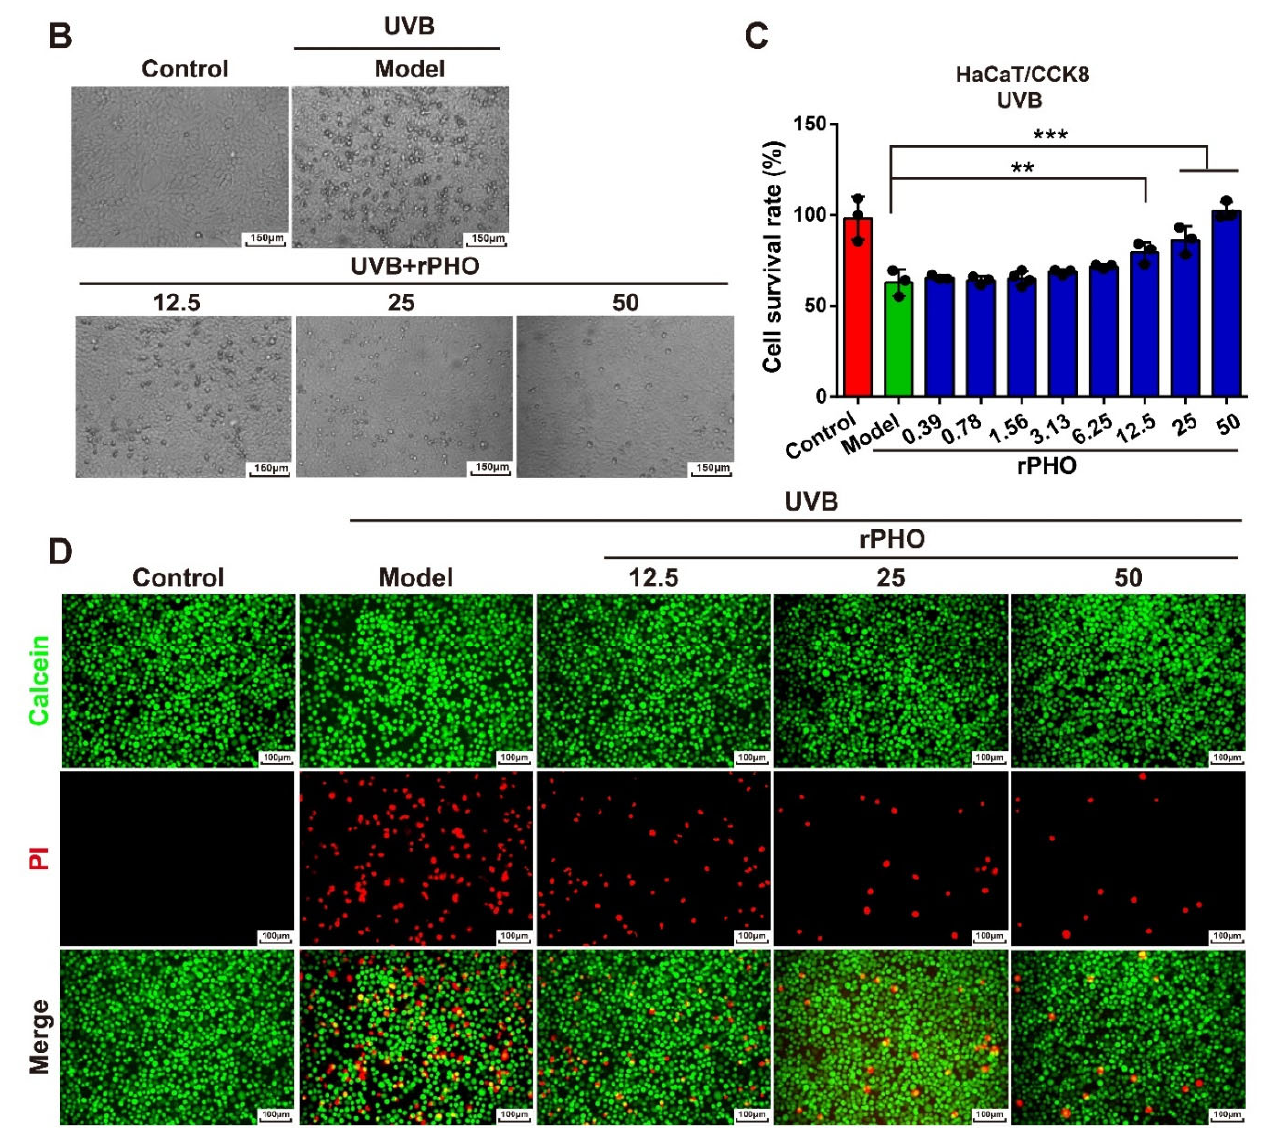
Figure 3. rPHO significantly reduced UVB ‐ induced death of HaCaT cells. ( A ) UVB irradiation ex ‐ perimental design. ( B ) Images of cells were obtained under a bright field by a microscope after rPHO treatment. Scale bar = 150 μ m. ( C ) Cell survival was measured. ( D ) Cells were stained with calcein ‐ AM/PI; dead cells were stained red and live cells were stained green. Scale bar = 100 μ m. Data are presented as means ± SD ( n = 3). ** p < 0.01, *** p < 0.001.